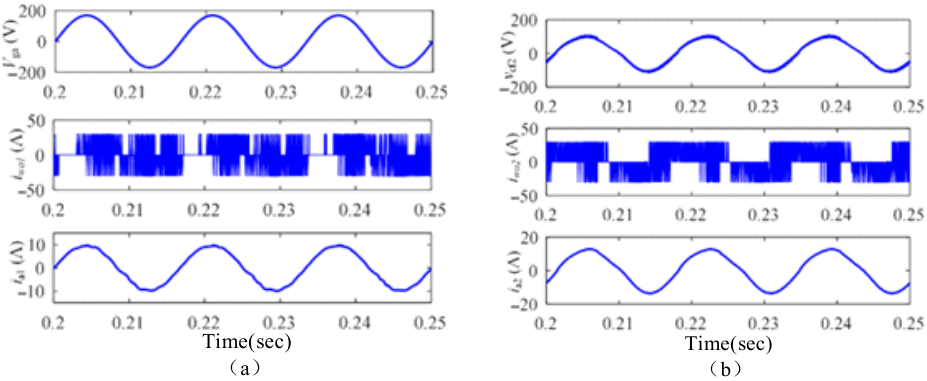
Figure 8. Performance under the same fundamental frequency; ( a ) rectifier side, ( b ) inverter side.